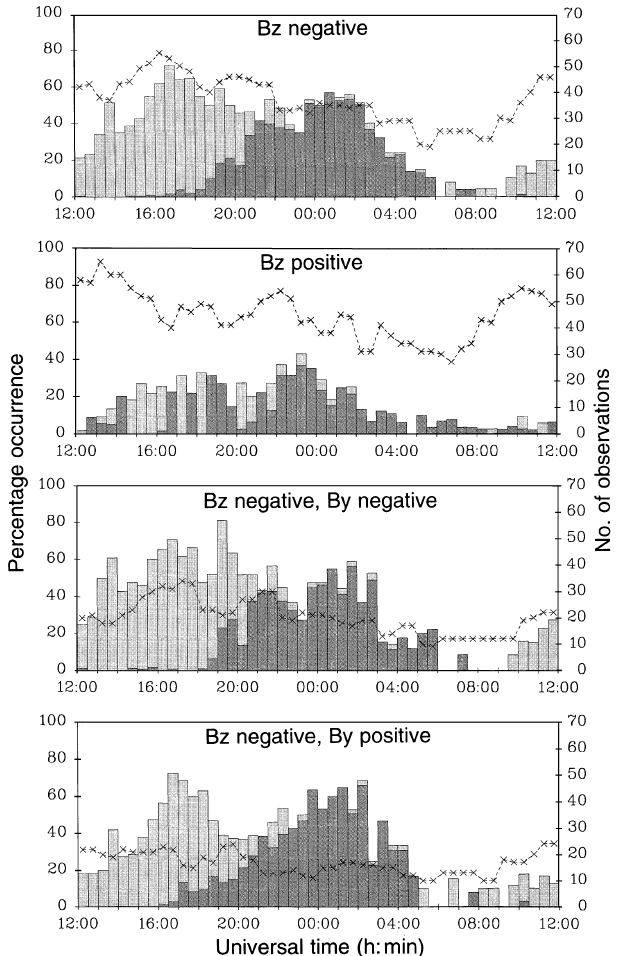
Fig. 7. Variation of the diurnal distribution of enhanced ion velocity with the orientation of the y and z components of the interplanetary magnetic field. Each panel is presented in the same form as